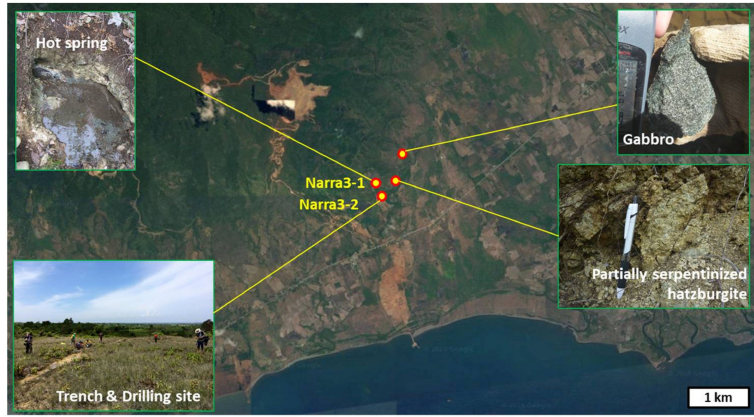
Figure 1. Overhead photo and sampling sites of the studied area.